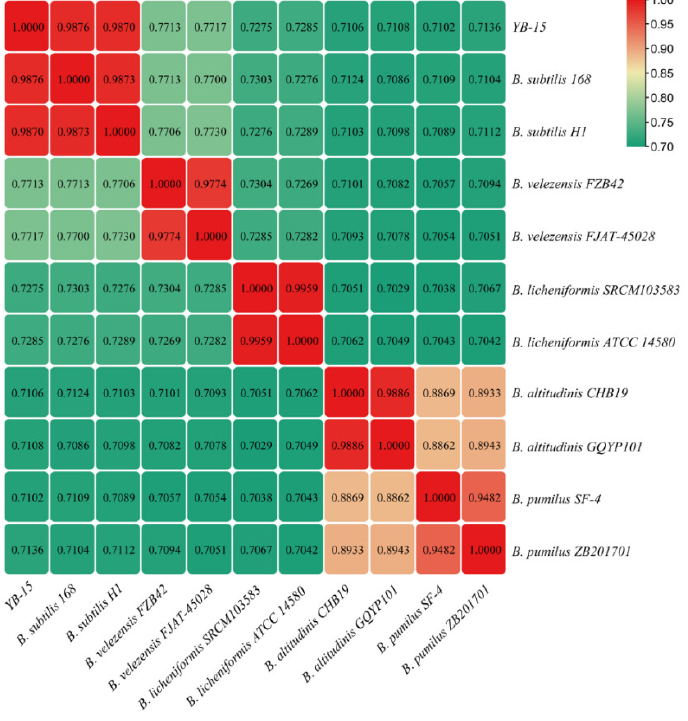
Figure 5. Heatmap of ANIvalues based on whole-genome sequences of B. subtilis YB-15 and 10 other Bacillus species.